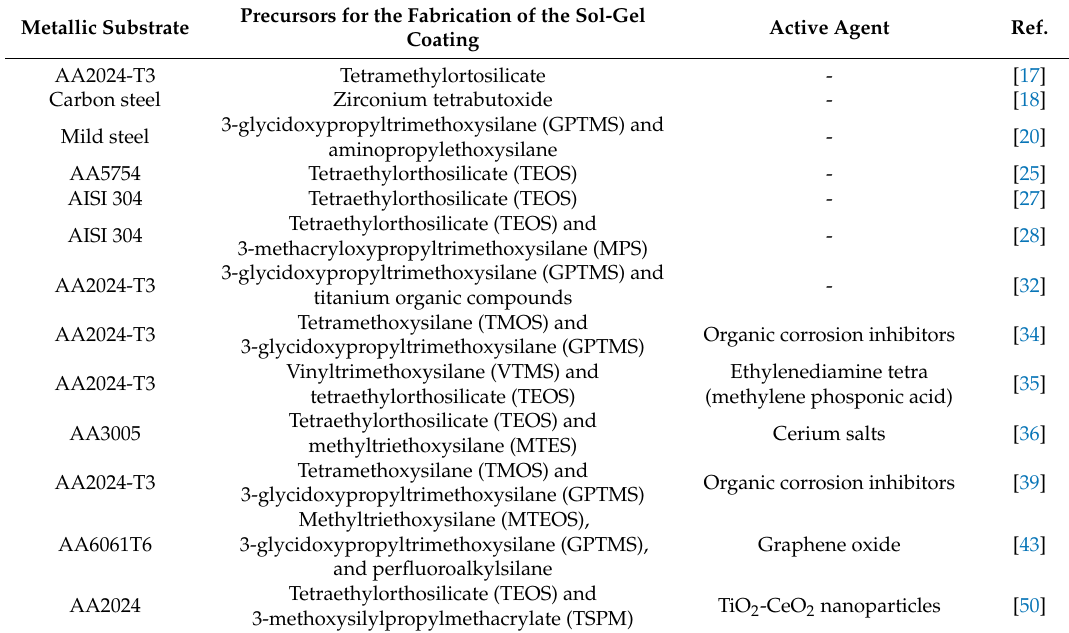
Table 1. Summary of the fabrication of different sol-gel coatings as a function of the selected substrate, precursors, and the presence or absence of active